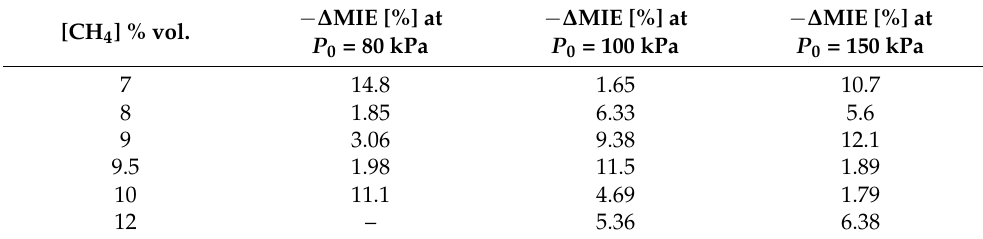
Table 4. MIE decrease in the presence of the 60 Co radioactive source.